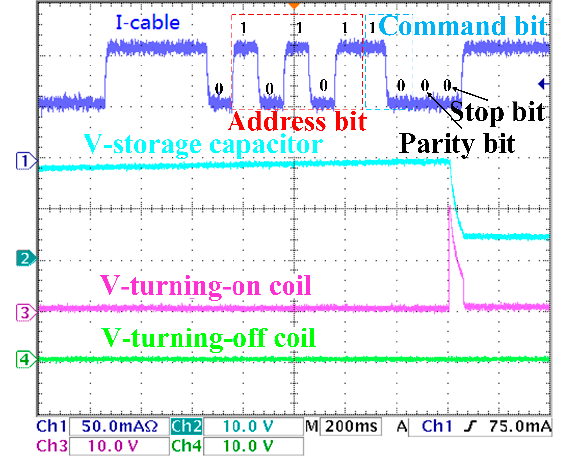
Figure 17. Turning-on command.